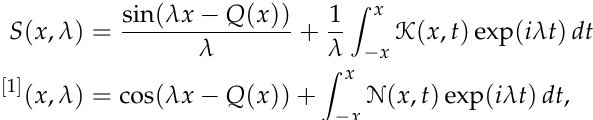
Algorithm 1 for recovery of the potentials q j ∈ W j